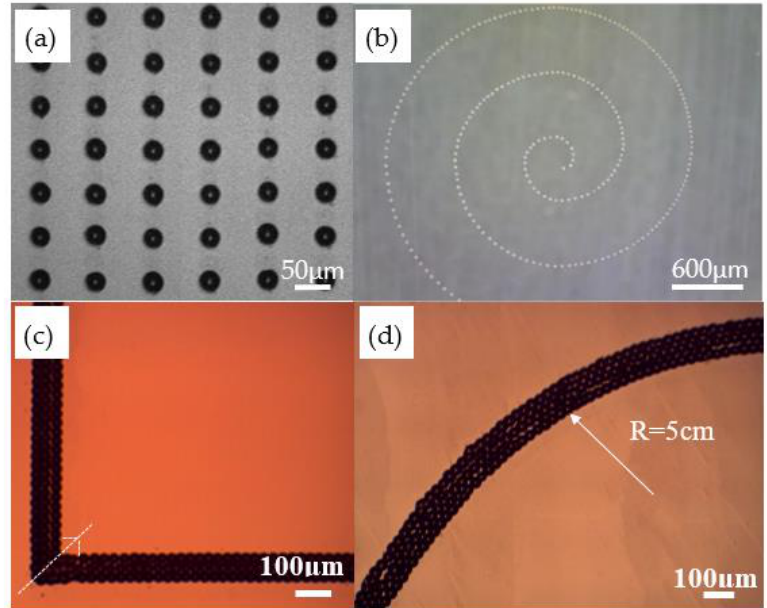
Figure 11. Printed MC-Wax microarray: ( a ) printed microarray with dot pitch measuring 80 µ m; ( b ) printed helix; ( c ) printed high fill rate corner construction; ( d ) printed high fill rate fillet construction.